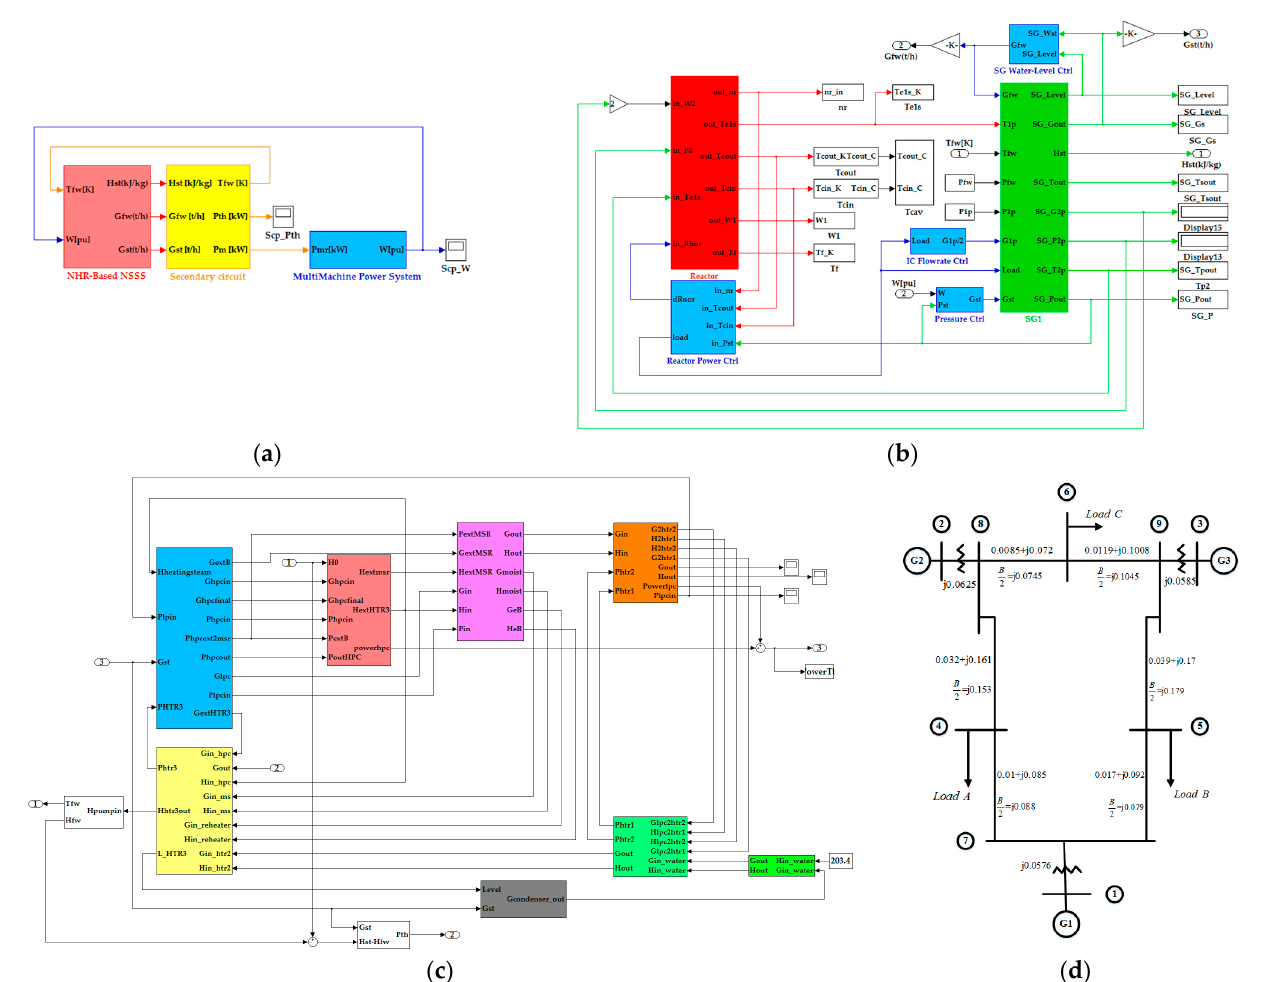
Figure 5. Simulation program and the corresponding three-machines/nine-nodes power system: ( a ) whole plant, ( b ) simulation unit of NSSS, ( c ) simulation unit of secondary system, ( d ) power system.